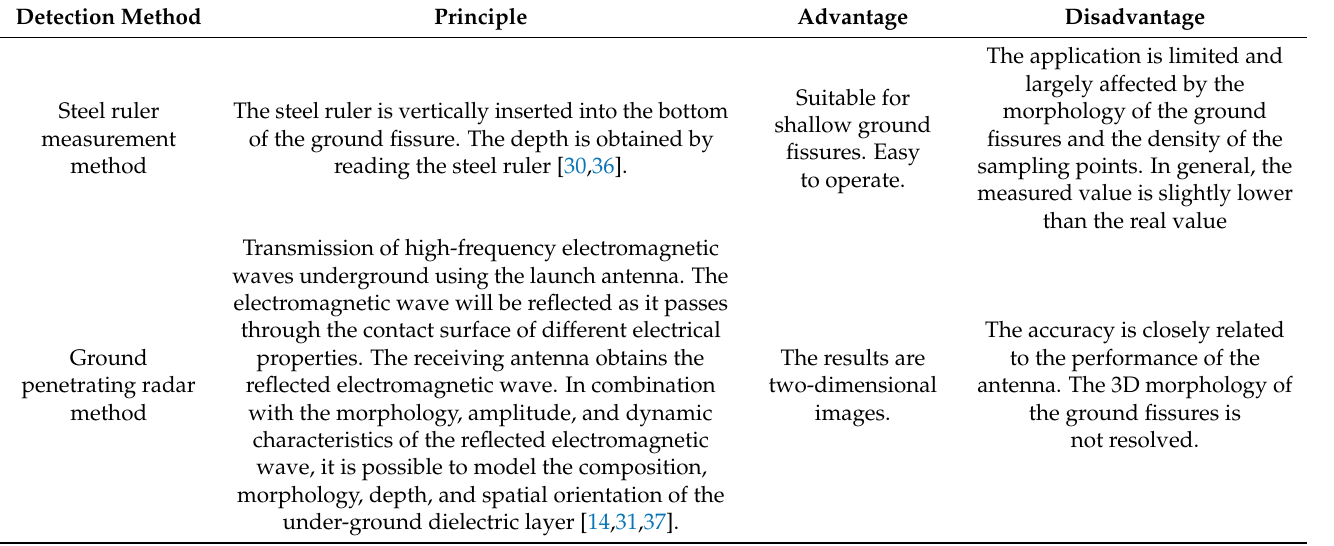
Table 1. The principles, advantages and disadvantages of various detection